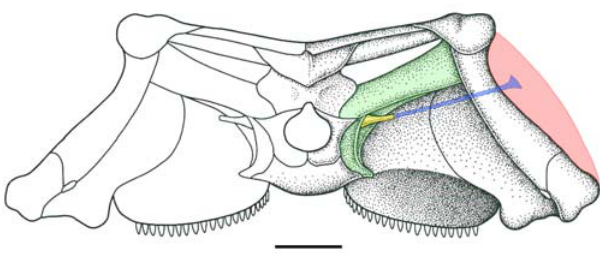
Figure 3. Middle ear reconstruction of Macroleter poezicus in occipital view. The paroccipital process (in green) is firmly attached to the dermal skull, the stapes (in yellow) is short and slender and was presumably connected to the tympanum (in pink) by an unossified extrastapes (in blue). Scale bar equals 1 cm.